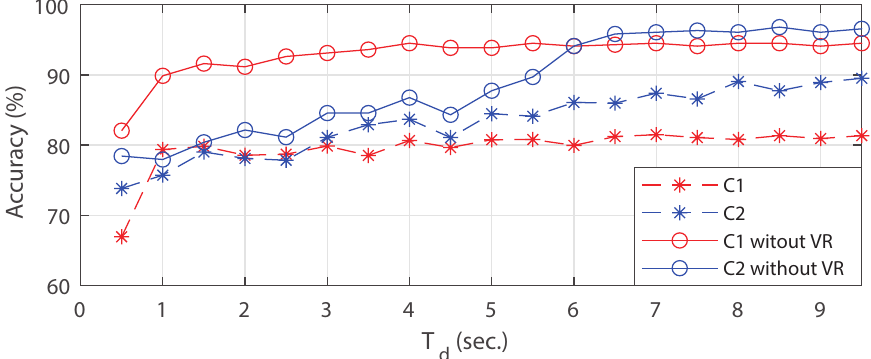
Figure 9. Performance of event location identification without windowing